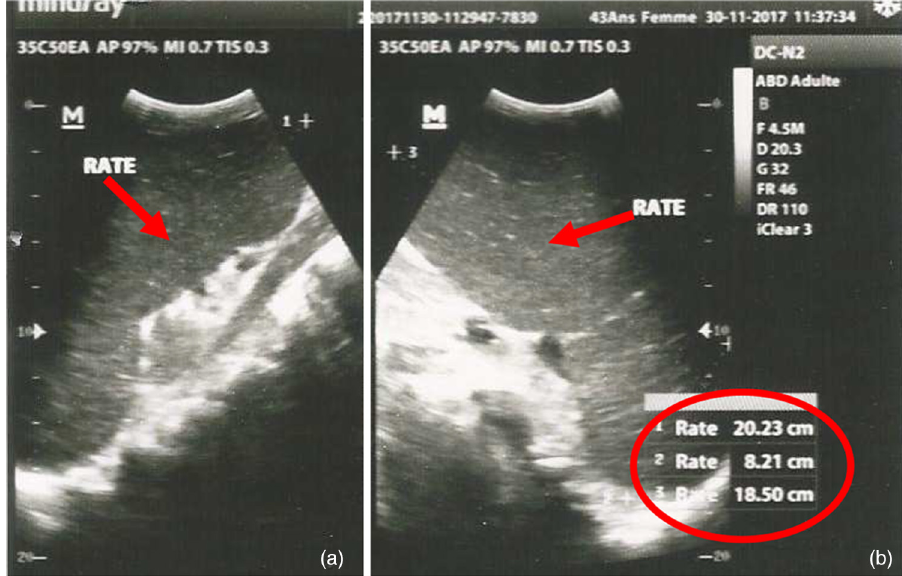
Fig. 2. a: Longitudinal section of the left hypochondrium passing through the spleen. b: Cross-section of the left hypochondrium passing through the spleen (splenomegaly,